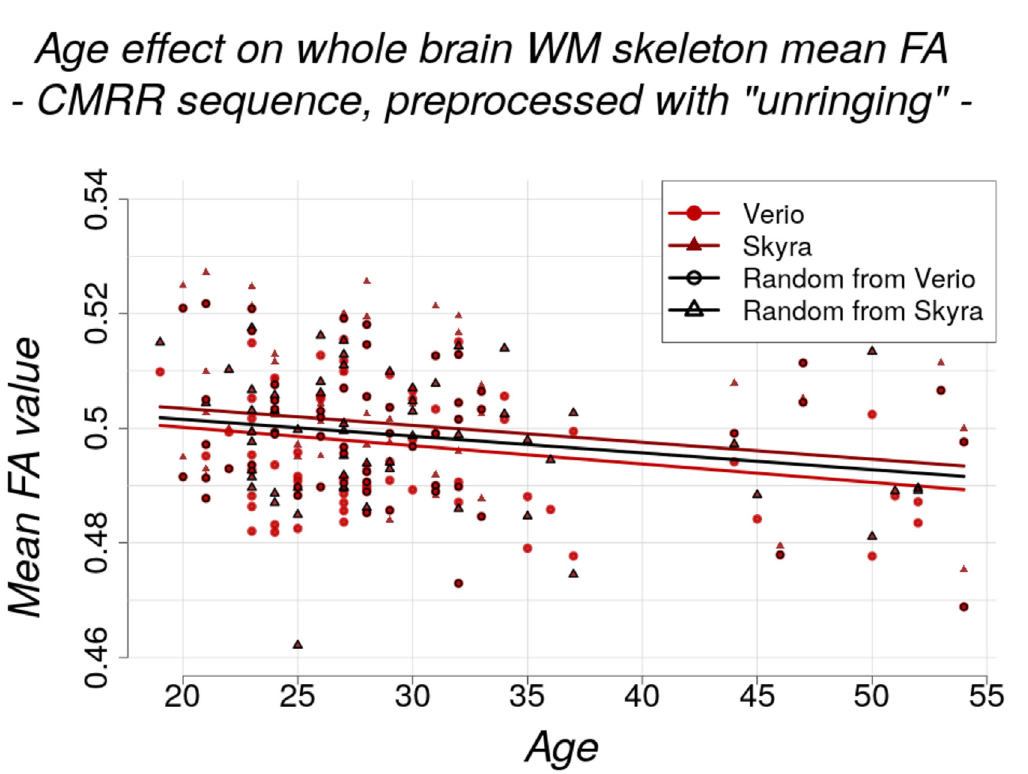
Figure 10. Negative effect of age on whole brain WM skeleton for both scanners separately (red circles: Verio, dark red triangles: Skyra, black framed circles and triangles: randomly selected to simulate pooled dataset from two different scanners). The effect modelled with linear modelling (mean FA value ~ age) is comparable between scanners (estimate ±